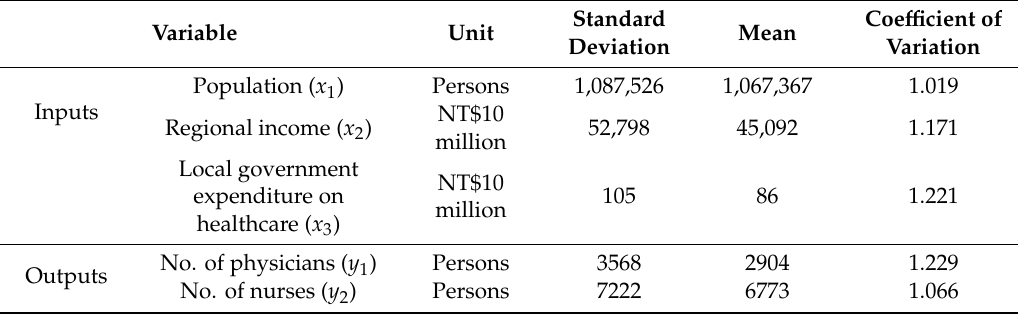
Table 1. Descriptive statistics of input and output variables.